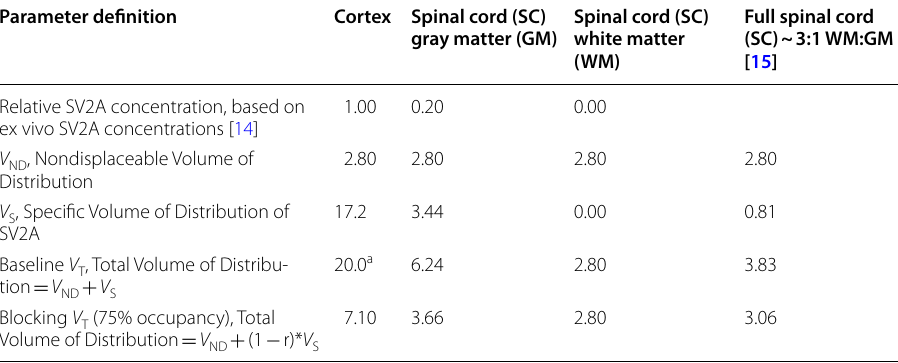
Table 1 Table of definitions and assumptions for simulation